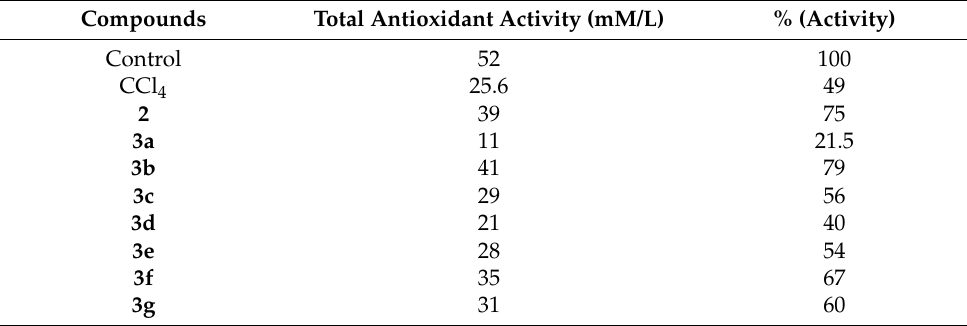
Table 3. Antioxidant activity of the tested compounds 2 and 3a – g .